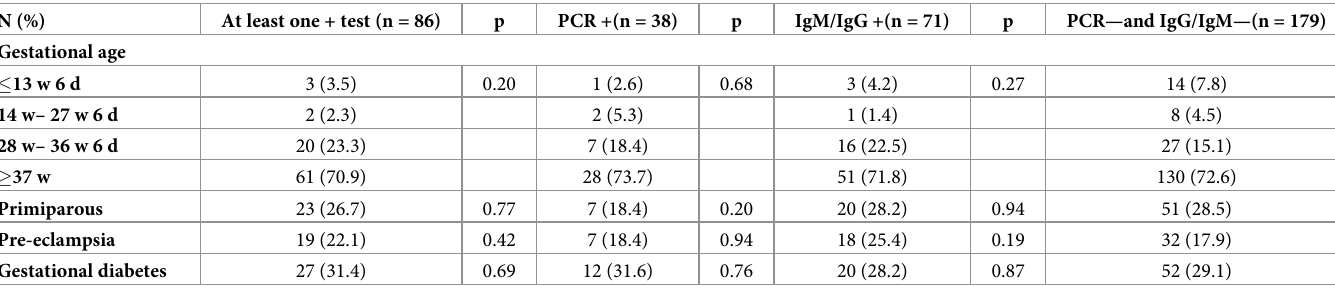
Table 2. Obstetric data by test type and result (N =